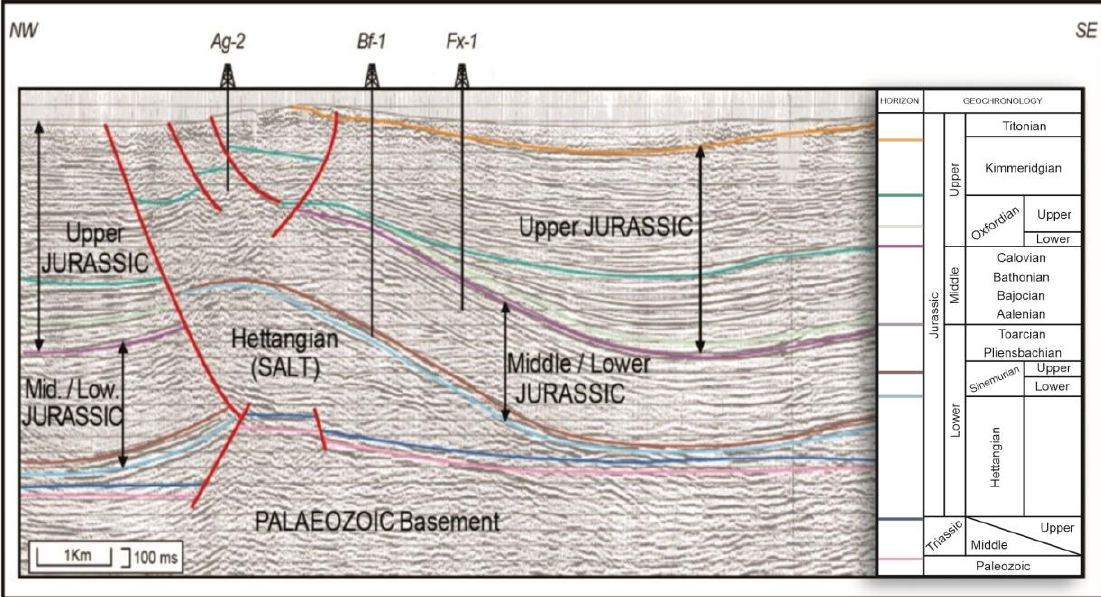
Figure 14. The 2D AR9-80 seismic reflection line interpreted. The Benfeito-1 (Bf-1) and Freixial-1 (Fx-1) exploratory wells drilled, respectively, 972 m and 1255 m thick in the Abadia Formation, adapted from Rasmussen et al. [26]. The occurrence of listric faults (in red) developed by the salt tectonics of the Dagorda Formation can be observed, which may have enabled the migration of hydrocarbons generated mainly in the Cabaços Formation (beneath the green reflector), and also in the Brenha Formation and the Paleozoic, to the turbidite sandstones of the Abadia Formation (beneath the orange